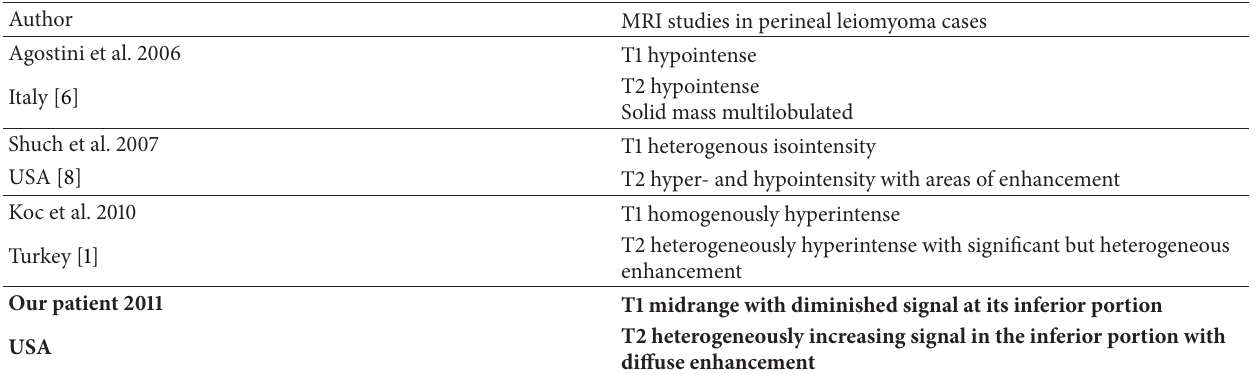
Table 3: MRI studies in perineal